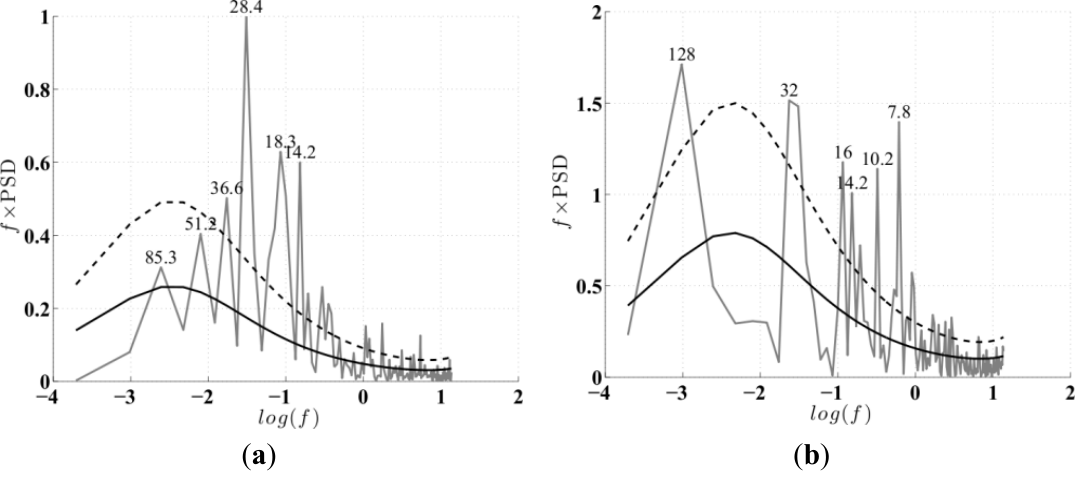
Figure 3. Variance-preserving spectra of Multivariate El Niño—Southern Oscillation Index ( a ) and Improved El Niño Modoki Index (IEMI) ( b ) with power spectra density (grey line), red noise spectra (solid black line), and 95% confidence line (dashed black line). The power spectra density (PSD) is normalized by the frequency ( f ) as indicated on the y-axis. Periodicity (months) of major peaks is also indicated. These maxima are significant against the background red noise and at the 95% confidence